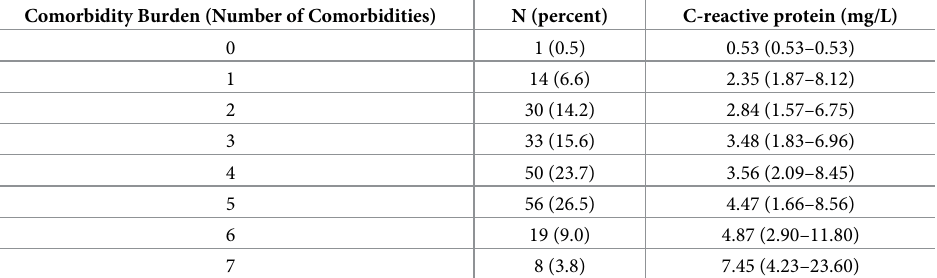
Table 2. Comorbidity burden and C-reactive protein (CRP) levels. CRP levels increased as the number of comor- bidities increased (parameter estimate 0.70 per increment in comorbidity number, 95%CI 0.14–1.27, P = 0.02),